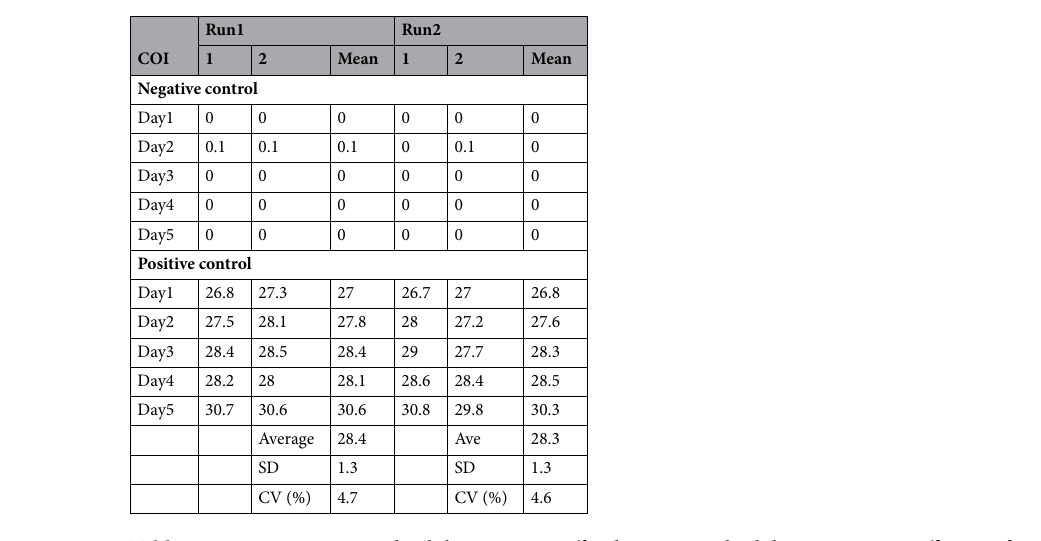
Table 2. Between-run reproducibility. COI cut-off index, SD standard deviation, CV coefficient of variation.